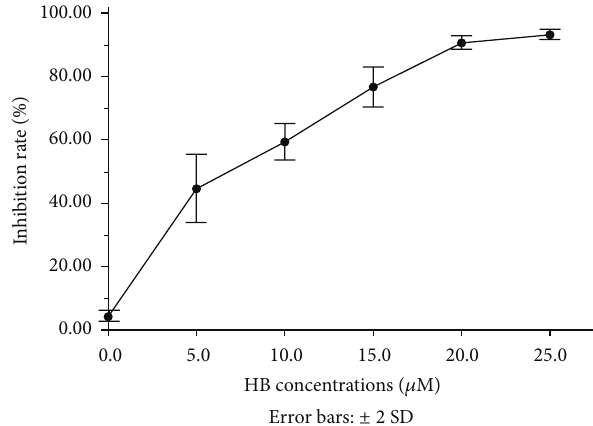
Figure 1: Inhibition of E. coli induced by photodynamic treatment of hypocrellin B. E. coli cells were incubated with different concentrations of hypocrellin B (0, 5, 10, 15, 20, and 25 𝜇 M) and irradiated by blue light with wavelength of 470 nm and energy density of 12J/cm 2